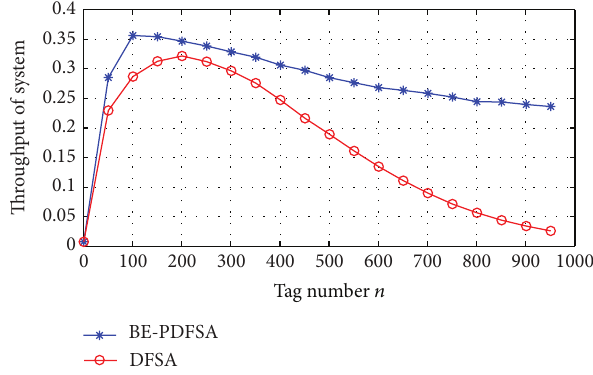
Figure 5: Comparison of throughput for algorithms.